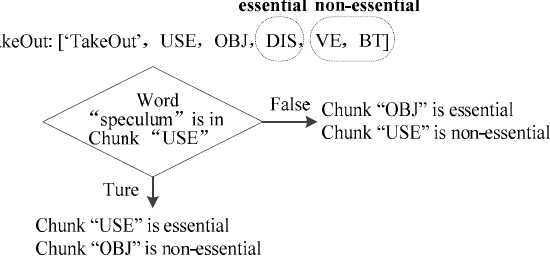
Figure 7. Example semantic framework.